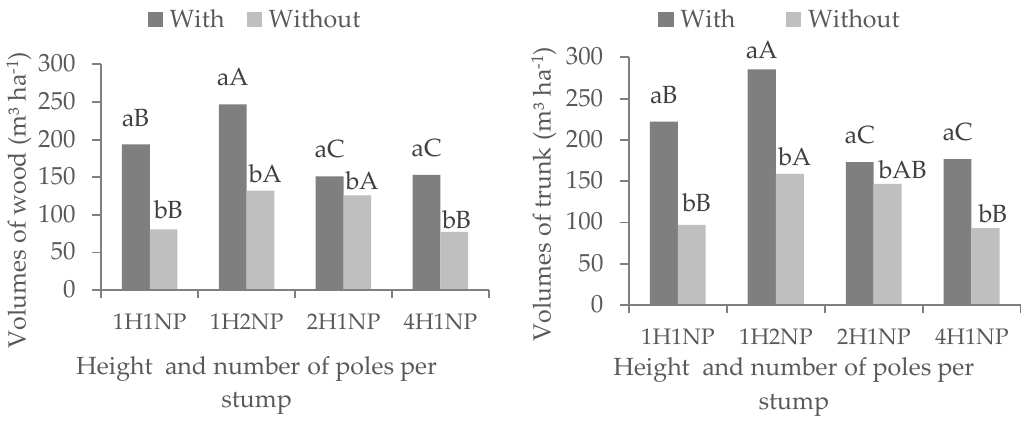
Figure 2. Volumes of wood and trunk of the clone GG157, at 60 months of age, influenced by liming/fertilization (With or Without), height (H) and number (NP) of poles per stump at the time of pole selection. Lowercase letters compare the effect of fertilization in the same treatment and uppercase letters compare the effect of the combination between height (H = 1, 2 or 4 m) and number of poles (NP = 1 or 2) left on the stump at the time of pole selection for the same fertilization condition (Tukey at 5%).